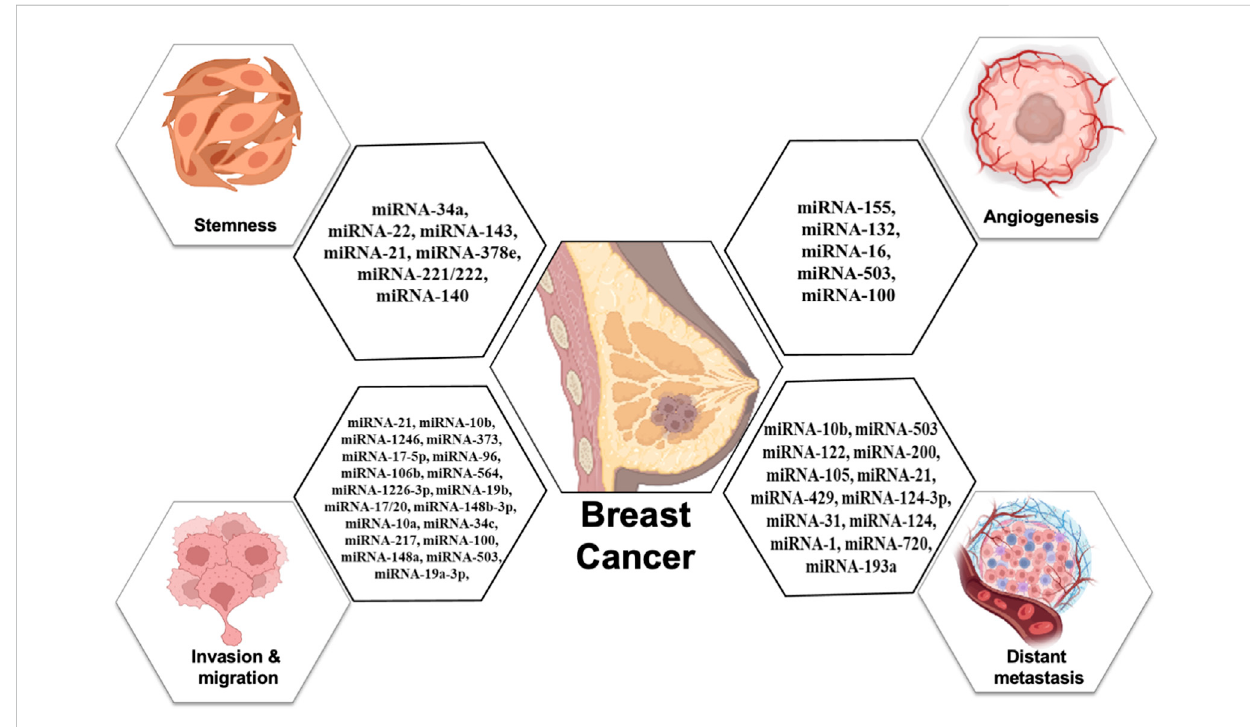
FIGURE 4 Role of exosomal miRNAs in different hallmarks of breast